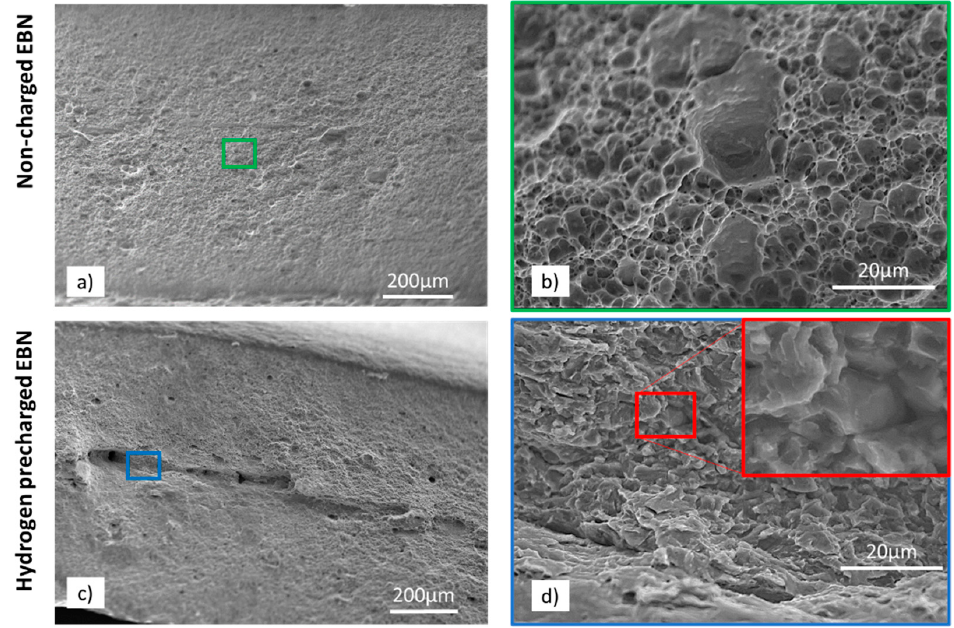
Figure 13. SEM fracture surface of non-charged EBN specimen ( a , b ) and hydrogen-charged EBN specimen ( c , d ).